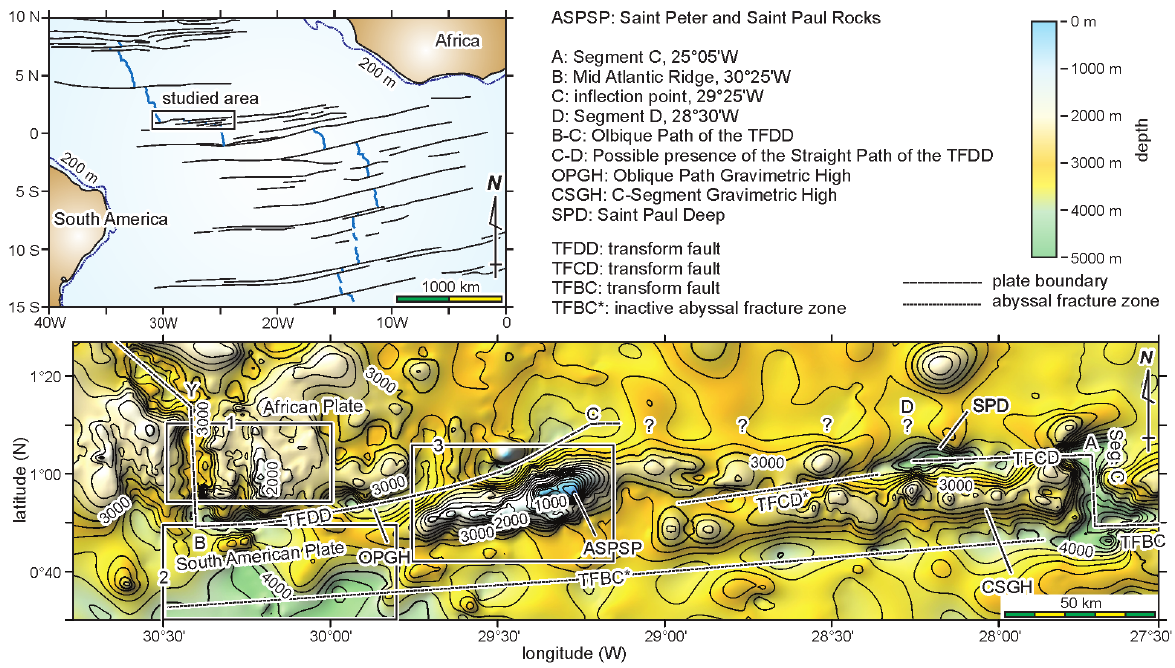
Figure 1 - Topographic map of the studied area based on the satellite-derived bathymetry of Global Topography ver. 14.1 of TOPEX. The plate boundary is after Sichel et al. (2011). ASPSP - Saint Peter and Saint Paul Rocks; TFBC, TFCD, TFDD - transform fault; TFBC*, TFCD* - inactive abyssal fracture zone. The rectangular areas 1, 2, and 3 are MCI (Massive Concavity Index) calculations data areas of Figure 16. The rectangular area 3 also indicates the data area for the gravimetric interpretation diagram of Figure